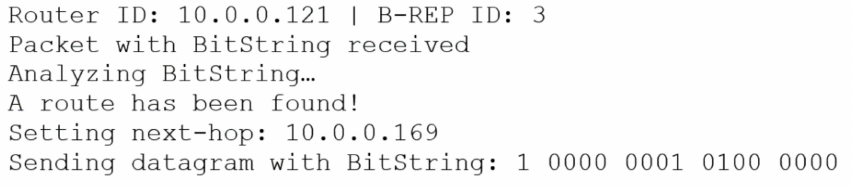
Figure 17. Output from R9—the processing of an EB-REP packet.